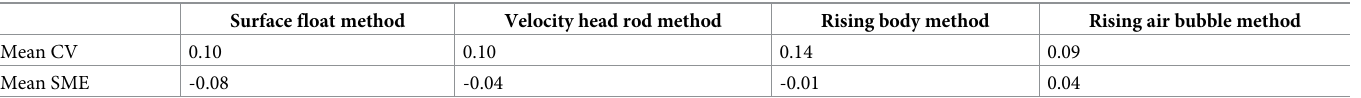
Table 2. Summary of precision and bias for each alternative